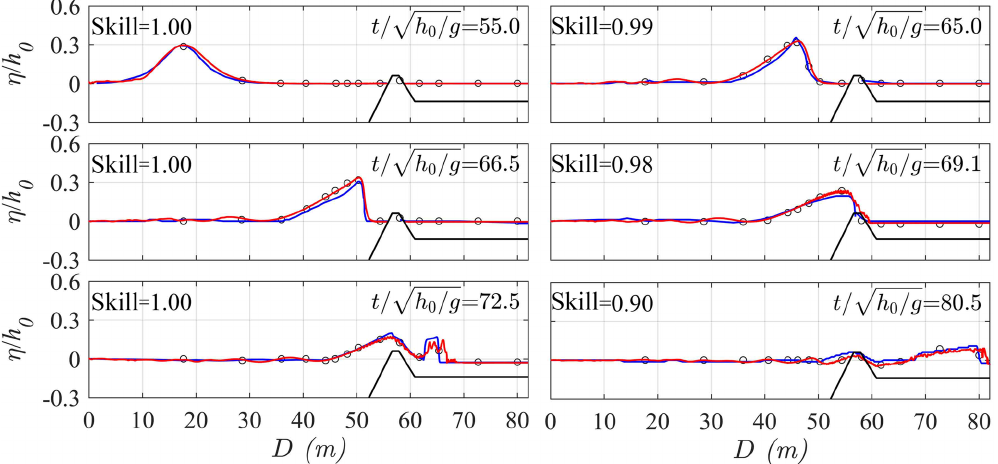
√ h 0 /g ) for Scenario 2. Red lines – present